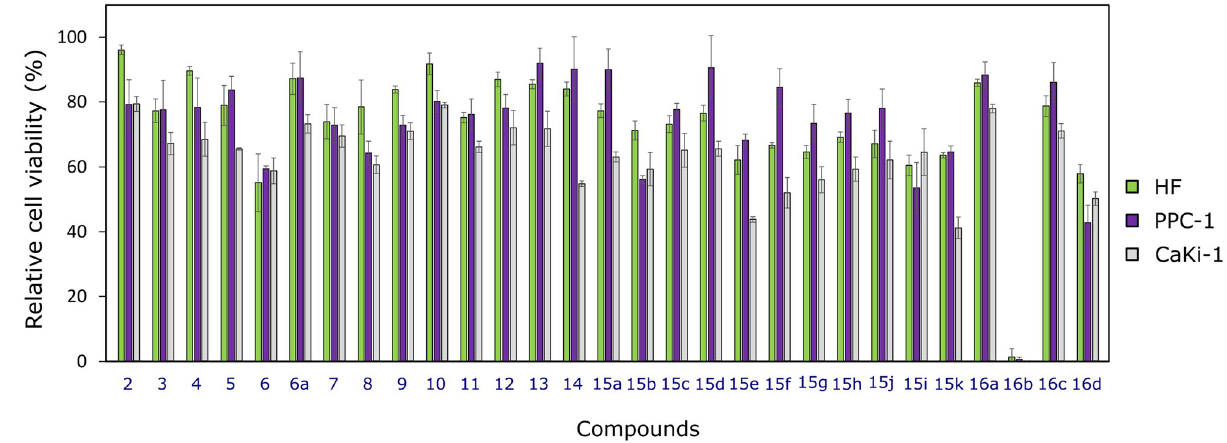
Fig 2. Effect of compounds on cancer cell viability at 100 μ M concentration against human prostate carcinoma PPC-1, human kidney carcinoma CaKi-1 cell lines, and human fibroblasts HF, n = 3.